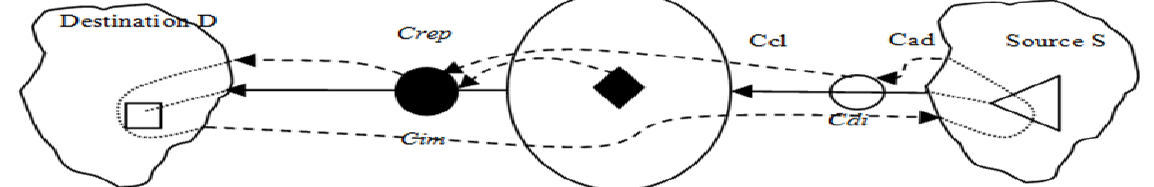
Fig. 3. The generation of counter